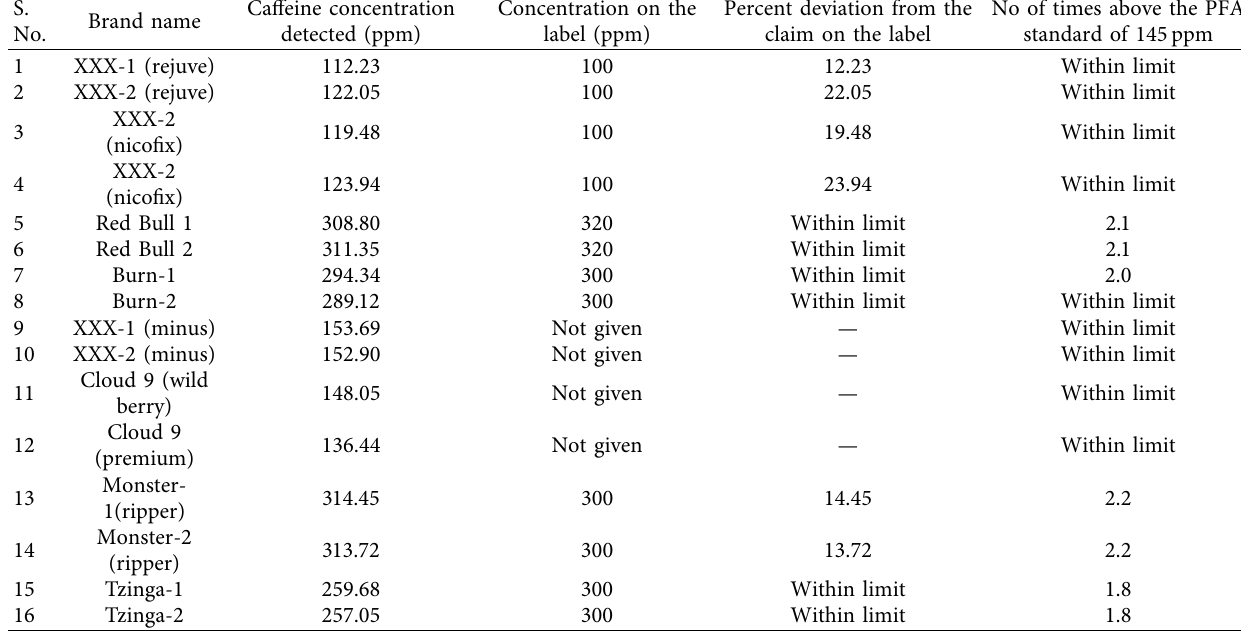
Table 1: Te cafeine content of popular energy